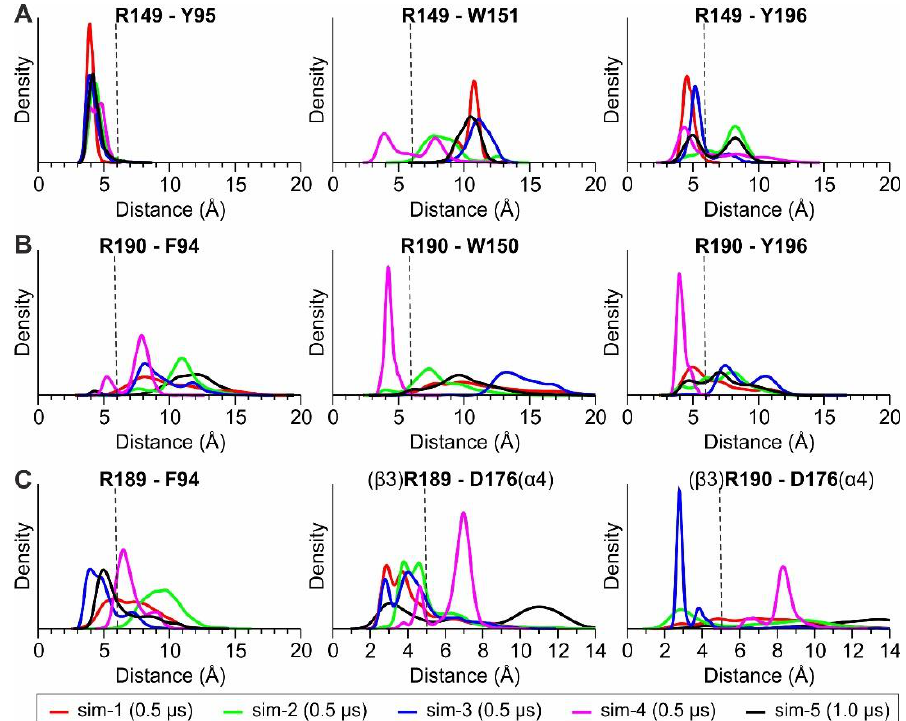
Figure 4. Probability density of the distances between ( A ) β2 - Arg149 and the β2 conserved aromatic residues Tyr95, Trp151 and Tyr196, ( B ) between β3 - Arg190 and the corresponding β3 residues Phe94, Trp150 and Tyr196, ( C ) between Arg189 or Arg190 of β3 and Phe94 of β3, or Asp176 of the adjacent α4 site. Distances were calculated between the geometric mean of the guanidinium atoms in arginine, and the aromatic atoms of the rings, or the carboxylate group of Asp176, whereas distributions were extracted using the kernel estimator in R. The dashed line indicates a proposed cut off for the distance occurring between cation – pi interacting species.